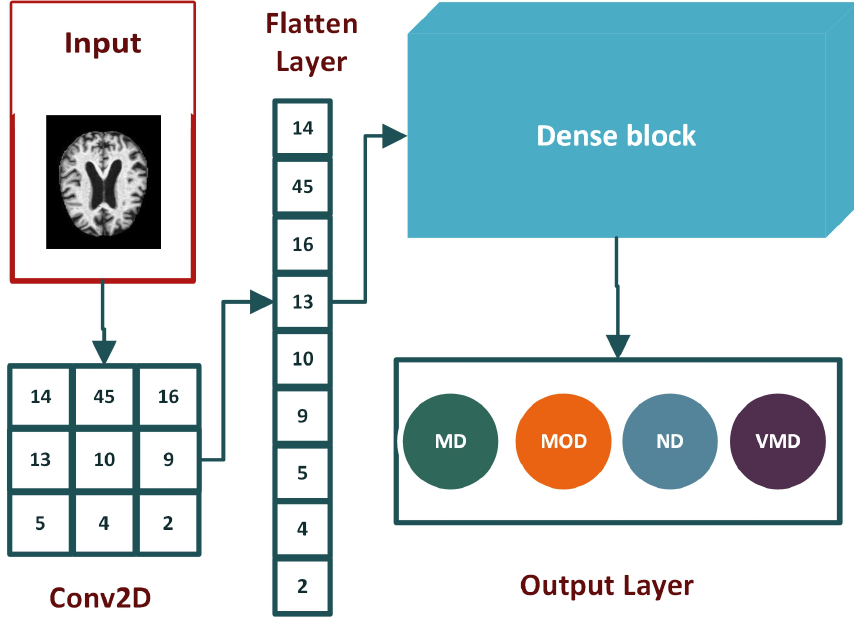
Figure 7. The overview of the architecture of the flattened layer used to vectorize the feature